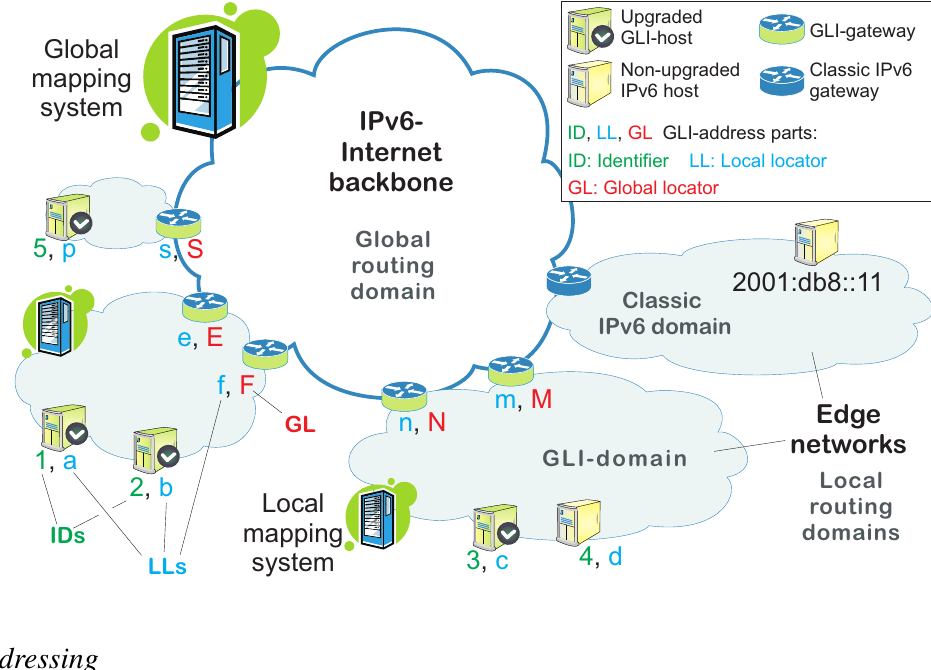
Figure 1. GLI-nodes and GLI-gateways have an identifier (ID) for identification and a local locator (LL) for routing in edge networks; in addition, GLI-gateways have a global locator (GL) which is used for routing in the IPv6